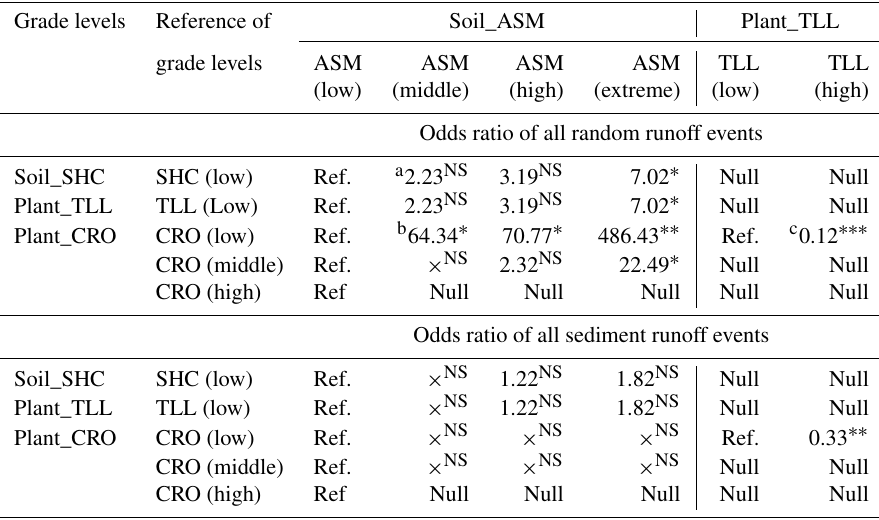
Table 7. Logistic regression model to analyse the interactive effect of rainfall, plant and soil ordinal variables on the erosion events pres- ence/absence in all restoration vegetation